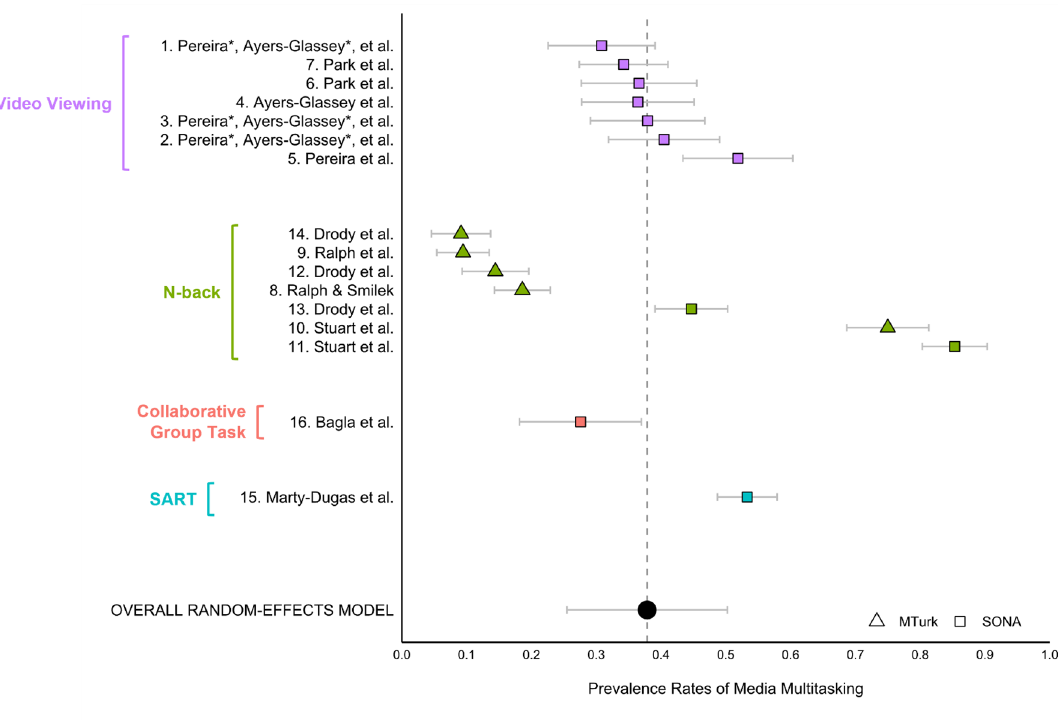
Figure 1. Prevalence Rates of Media Multitasking across Studies. Forest plot depicting means and 95% confidence intervals for prevalence rates of media multitasking within each dataset, as well as the point estimate for the overall random-effects model. Coloured labels on the left indicate type of task. Prevalence rates of media multitasking ranged from 0.09 to 0.85, with no differences found across method of recruitment, type of task, length of task, gender of participant, or question